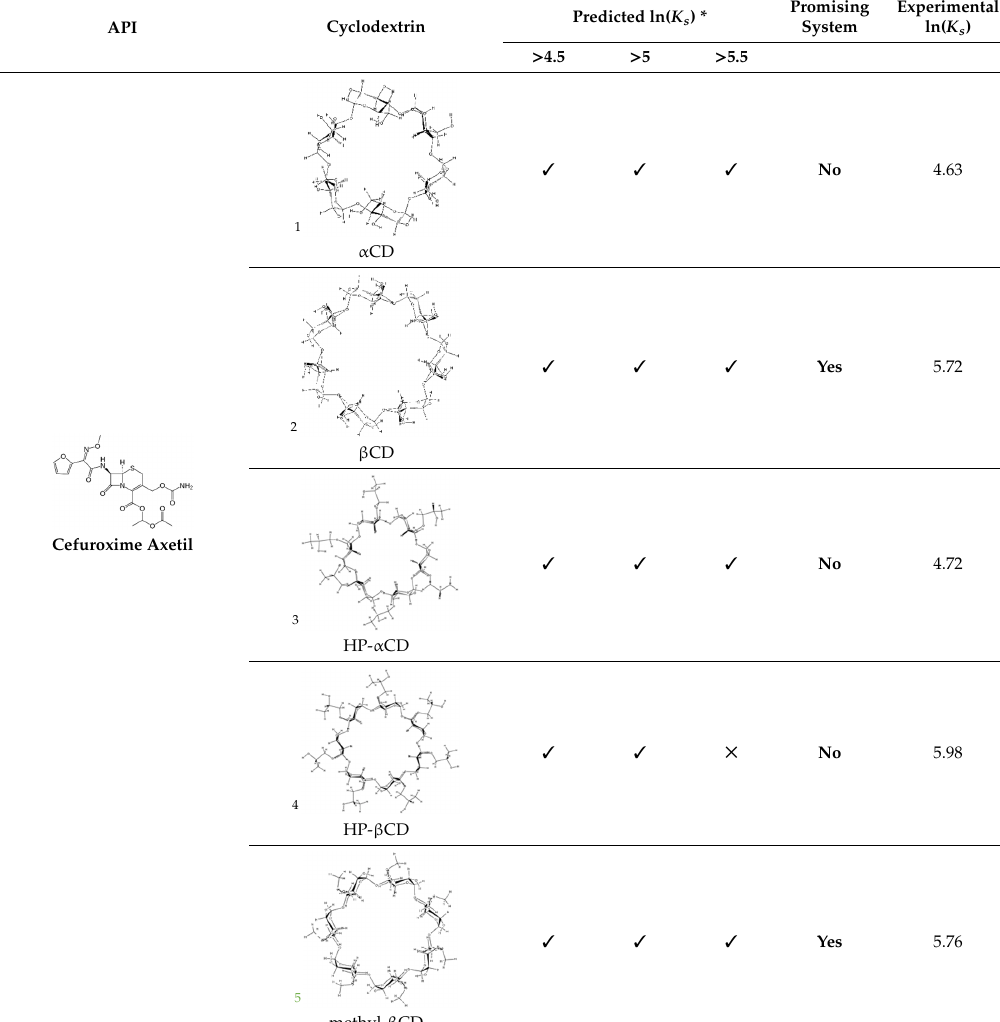
Table 3. Results of experimental validation. Comparison of predicted versus actual stability classes for di ff erent cefuroxime axetil (CA)–CD systems and di ff erent ln( K s ) thresholds for binary data division. Measured experimental ln( K s ) values are shown in the last column of the table. Promising Predicted ln( K s ) * API Cyclodextrin